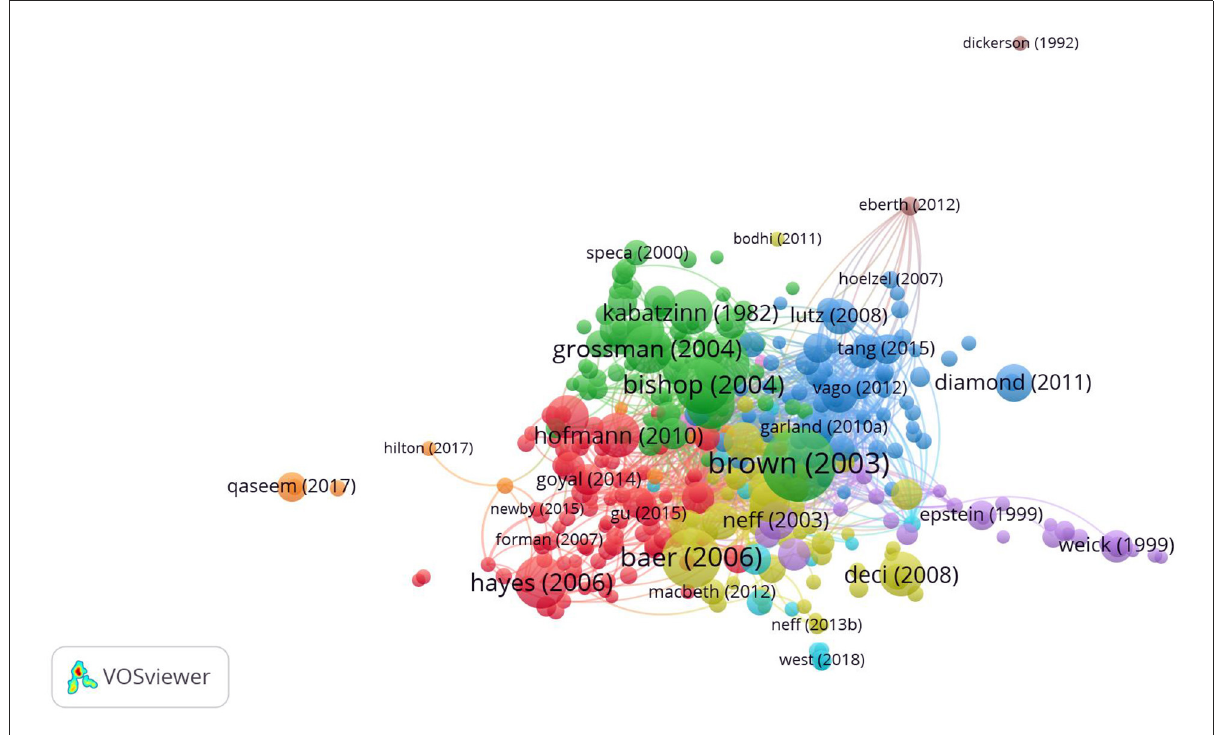
FIGURE4 Network visualization of bibliographic